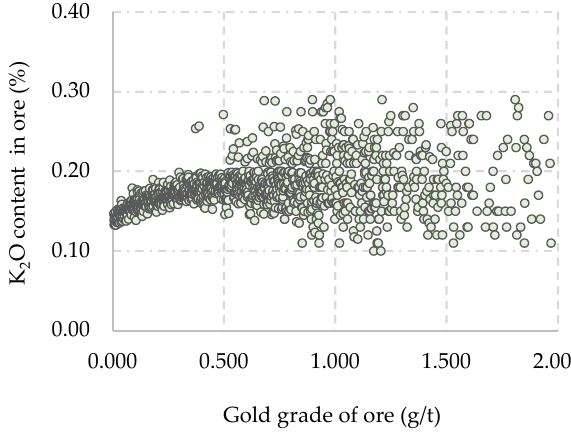
Figure 7. Scatterplot of aluminium oxide versus gold grade.